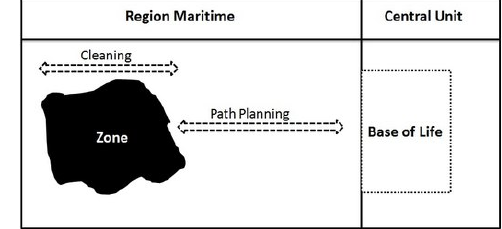
Figure 15: Example of a simplistic virtual environment.